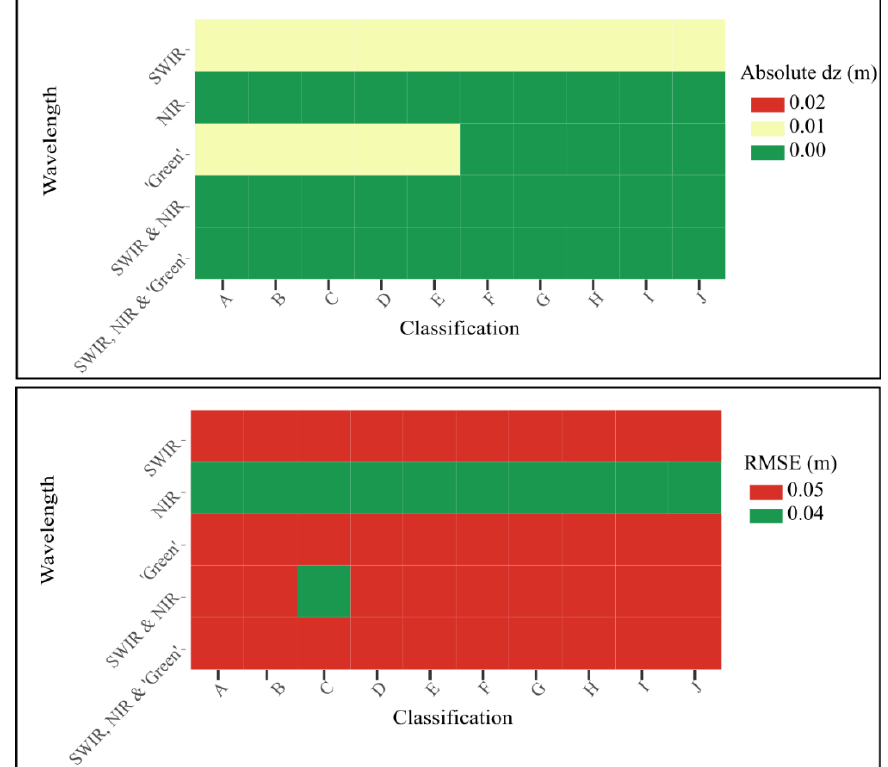
Figure 5 . Ground classification results (| 𝑑𝑧̅̅̅ | and RMSE) along a flat road surface for baseline comparisons using parameterization methods in Table 2. Classifications were conducted in LAStools.